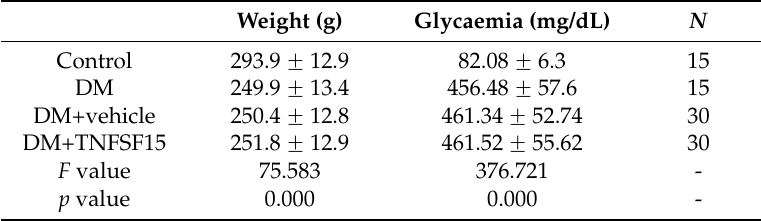
Table 2. Weight and blood glucose levels of rats from different groups.